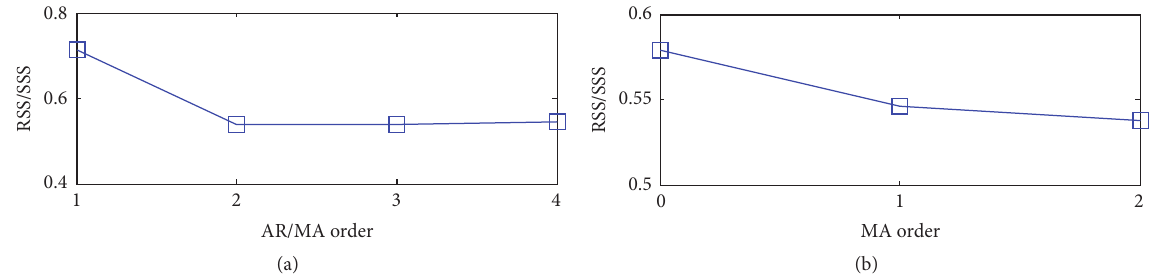
Figure 4: Exponentially weighted RPLR-TARMA model order selection: (a) AR order and (b) MA order.